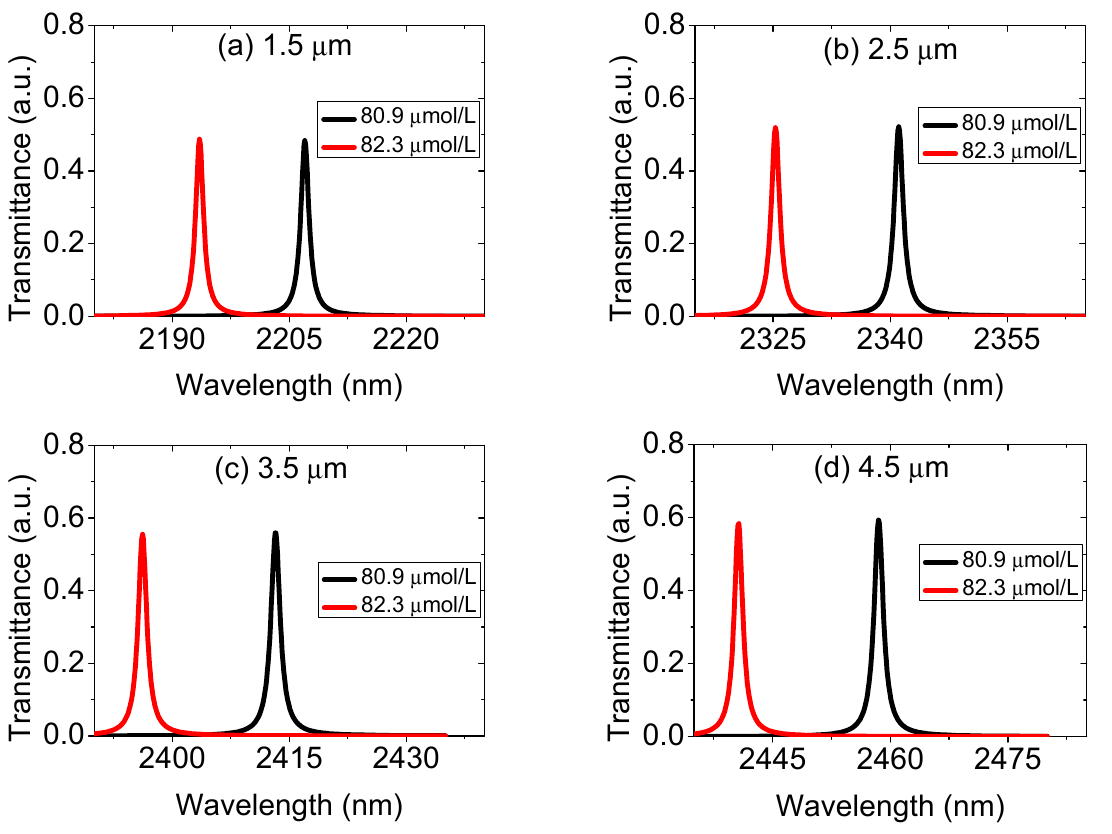
as the thickness of the cavity layer rises from h f = 0.5 µ m to h f = 5.5 µ m, as shown in Figure 8. By increasing the thickness of the cavity layer to greater than h f = 5.5 µ m, a few increases in the sensitivity are noticed. As a result, the optimal thickness of the cavity layer is h f = 5.5 µ m. Moreover, their intensity gradually grows and reaches the maximum at a cavity layer of thickness 5.5 µ m. The maximum value of intensity is always desired for a good-performing biophotonic sensor. As the thickness of the cavity layer increases, the electromagnetic wave will have a longer geometric path through the cavity, and a greater interaction occurs between the incident wave and the sensing sample. As a result, the sensitivity and intensity of peaks are improved. Thus, the optimum thickness of the cavity layer is selected as 5.5 µ m. The calculations of defect mode positions, wavelength shift, and sensitivity for all these thicknesses of cavity layers are presented in Table 4.